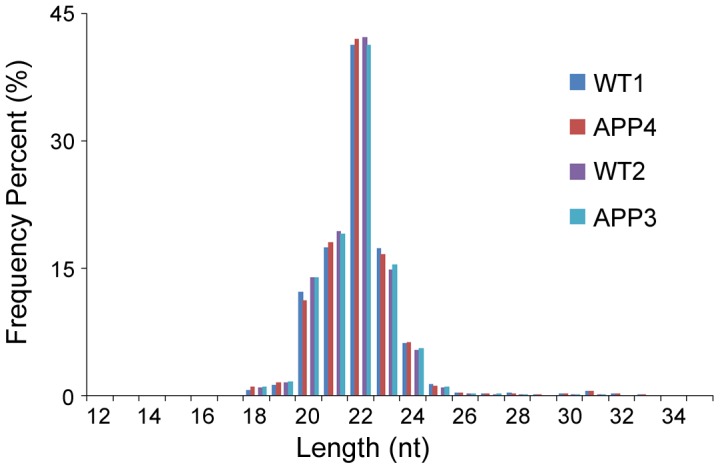
Length distribution of the annotated sequences.All four libraries from the two groups (WT1/APP4 and WT2/APP3) accumulate 22-nucleotide small RNAs, which is consistent with the typical size of miRNAs.